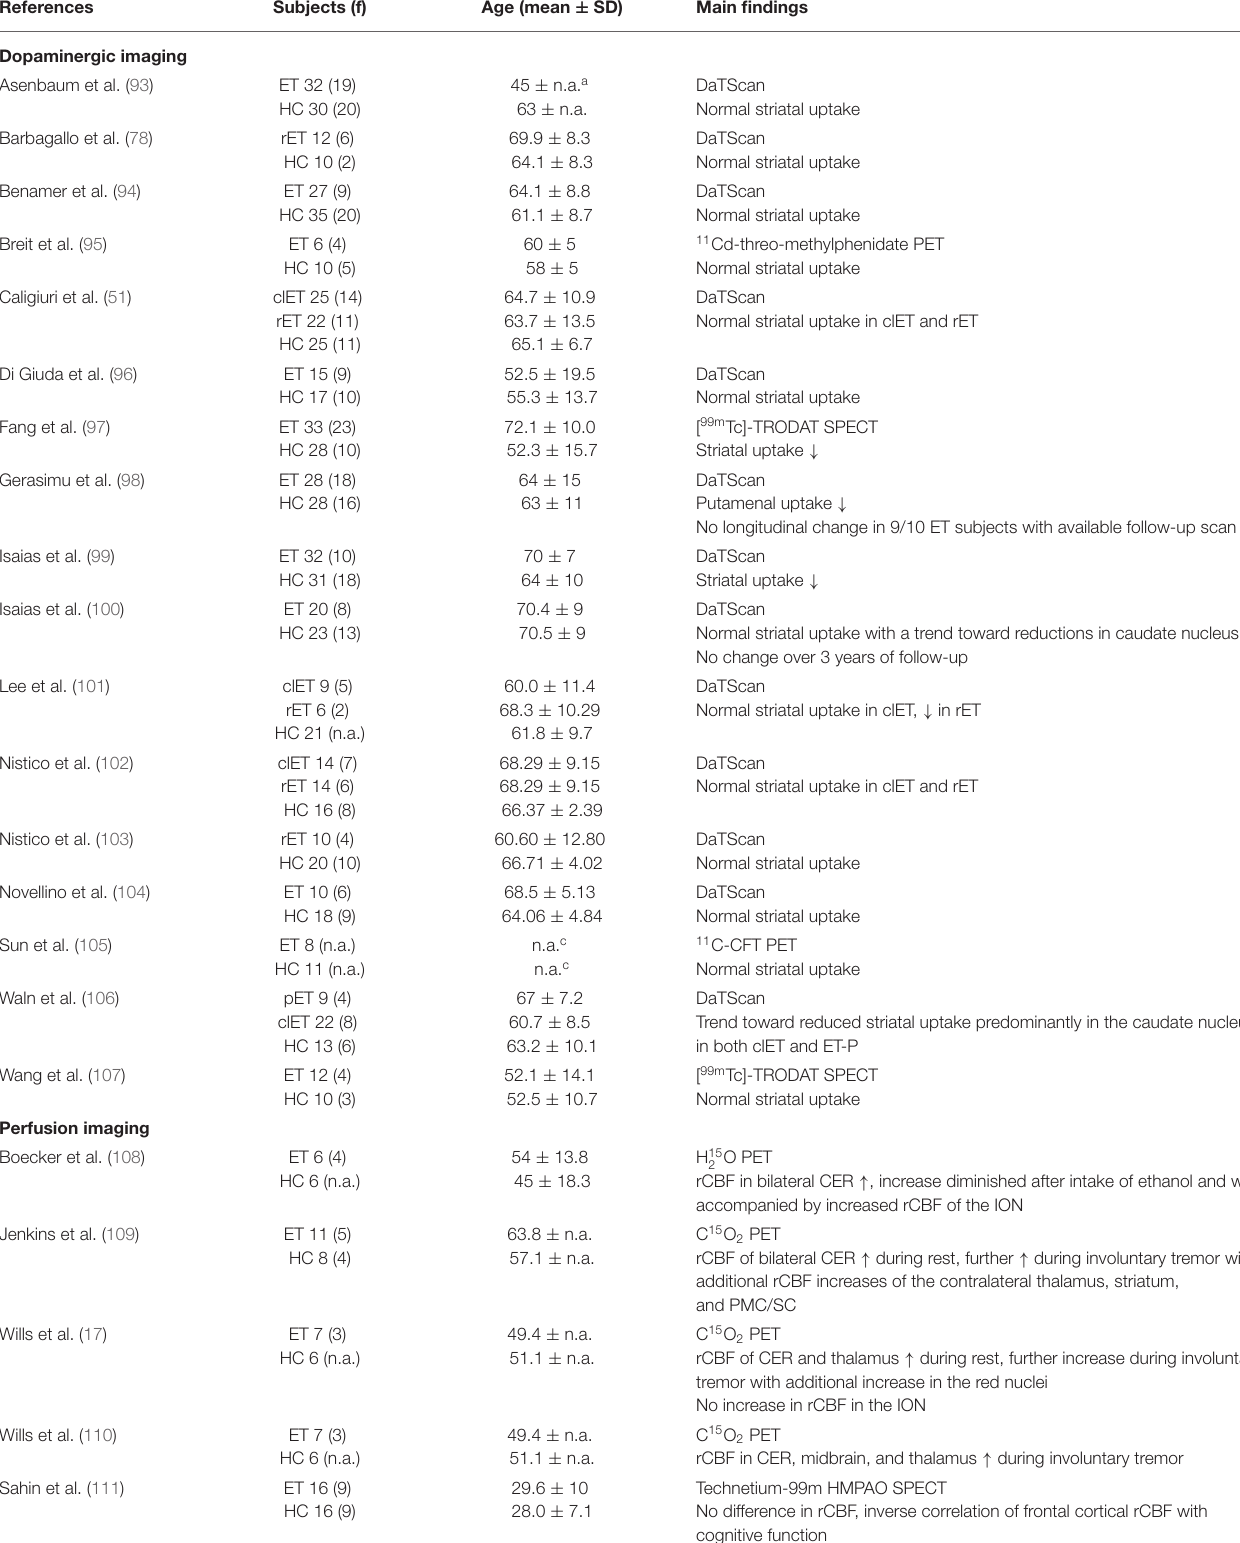
TABLE 2 | Summary of radiotracer